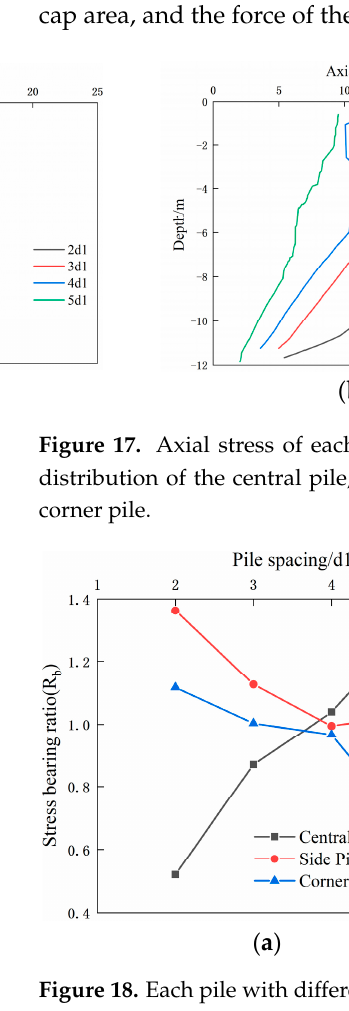
( d ) Figure 19. Q-s curve of stiffened core: ( a ) pile spacing is 2d1; ( b ) pile spacing is 3d1; ( c ) pile spacing is 4d1; ( d ) pile spacing is 5d1.